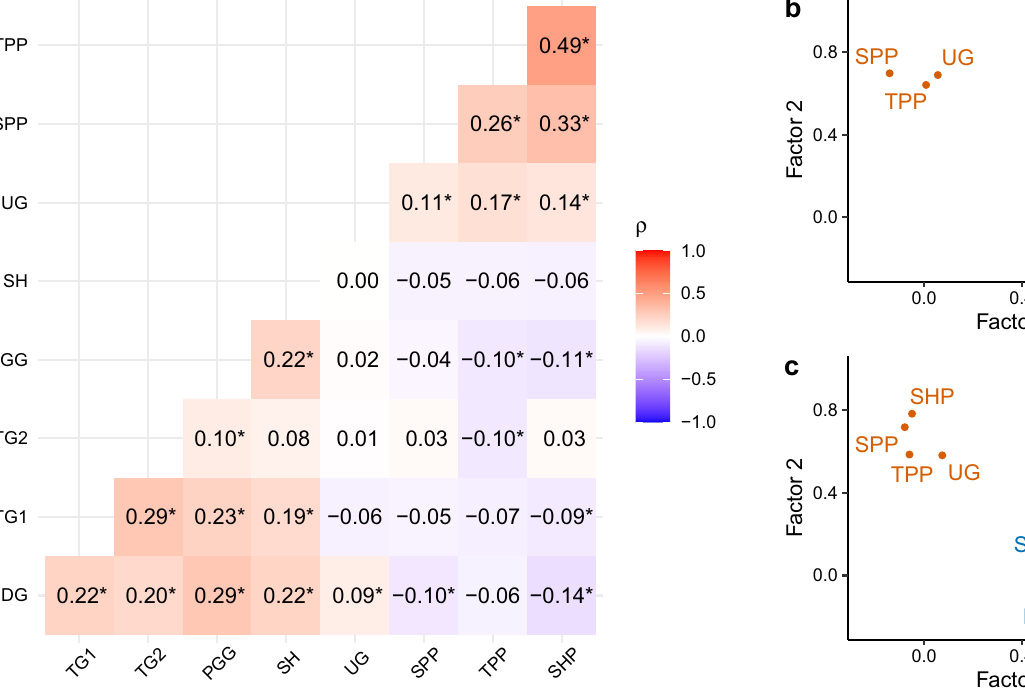
Figure 1. Factor structure of economic games. ( a ) Pairwise Spearman’s rank correlations for game decisions. * indicates significant correlations with Benjamini-Hochberg corrected p values ( p < 0.050 ). ( b ) Factor loadings from a principal components analysis with only the game decisions from previous work 47 . ( c ) Factor loadings from an extended principal components analysis including coordination games. DG = Dictator Game, TG1 = Trust Game (Give), TG2 = Trust Game (Return), PGG = Public Goods Game, SH = Stag Hunt Game, UG = Ultimatum Game (Minimum Acceptable Offer), SPP = Second-Party Punishment Game (Punish Defector), TPP = Third-Party Punishment Game (Punish), SHP = Stag Hunt Game with Punishment (Punish